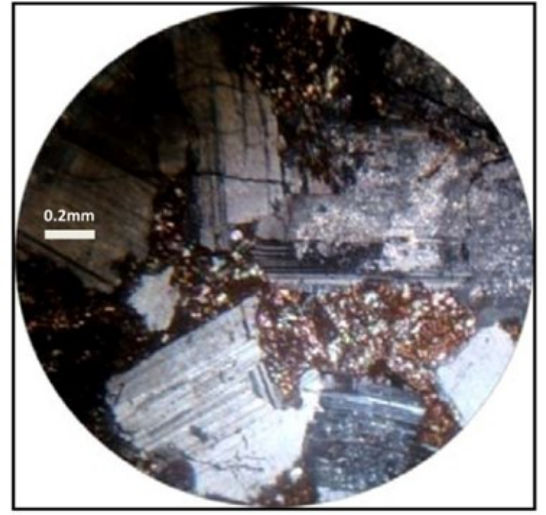
Fig. 5. Brecciated microsyenite (UD010). Phenocrysts interstitial spaces filled with muscovite-